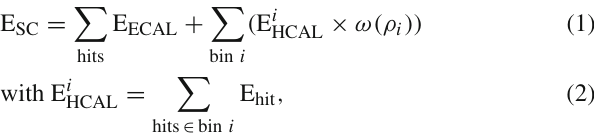
Fig. 2 Distribution of the hit energy density for a sample of K 0 neutrons with 30 GeV energy. One MIP per cell corresponds to approx- imately 1 GeV/1000cm 3 . The differently shaded areas show the sub- division into energy density bins used for the software compensation